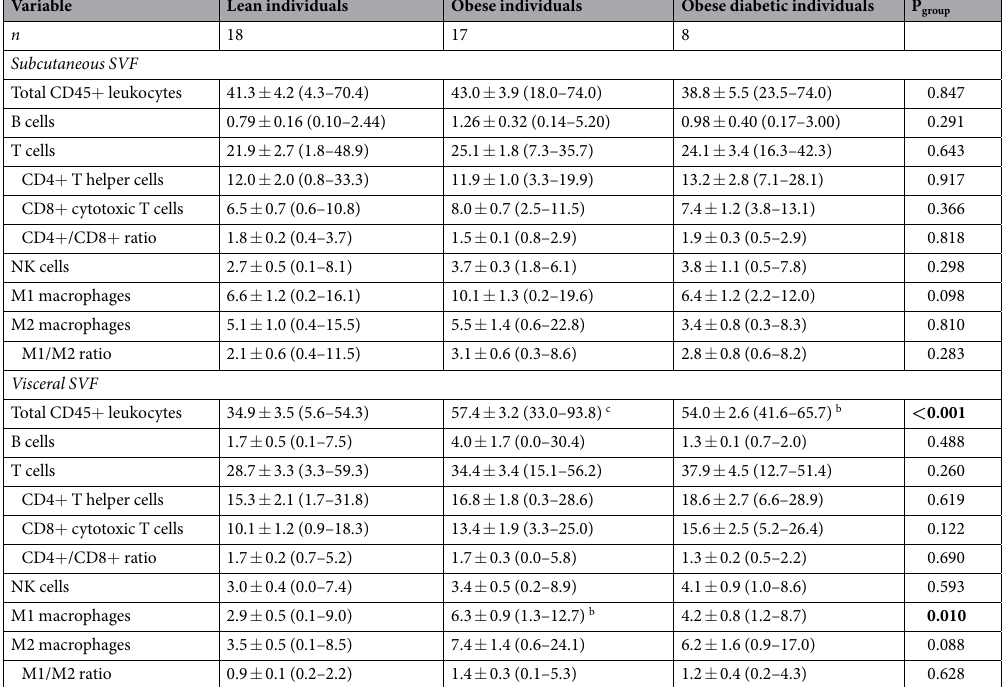
Table 2. Frequency of cell populations in subcutaneous and visceral SVF determined by flow cytometry. Data are mean ± S.E.M (range). Cell frequencies are expressed as % of total cells; NK, natural killer; CD, cluster of differentiation; SVF, stromal vascular fraction. Significantly different from lean group ( a p < 0.05; b p < 0.01; c p <